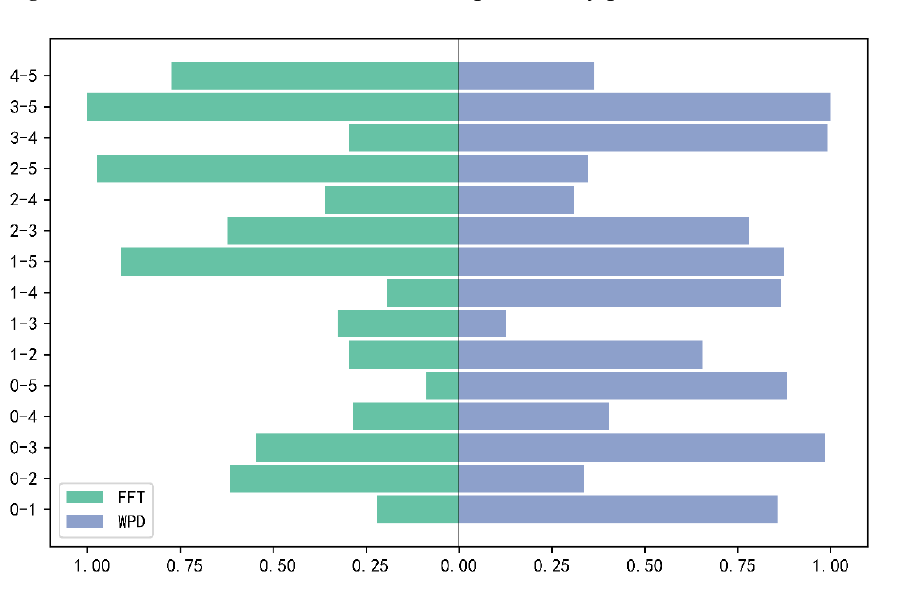
Table 3. The accuracy (%) table with different parameters. Ratio